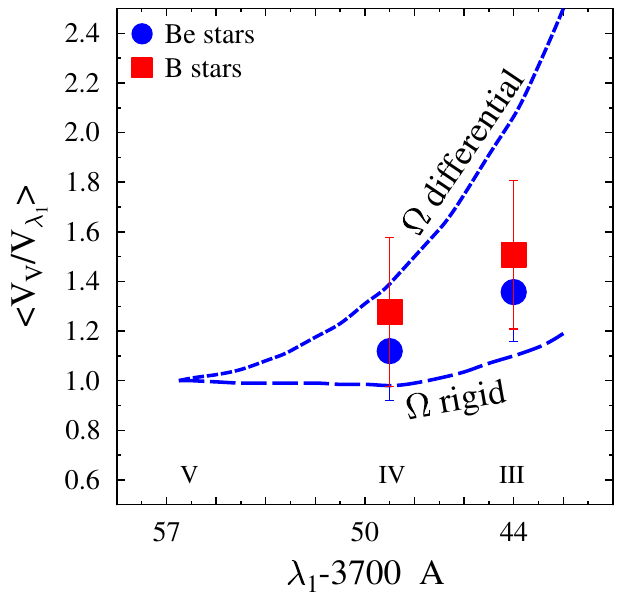
(cid:105) ( (cid:104) V Figure 32. Average true rotational velocity ratios (cid:104) V V / V λ V = true rotational velocity of stars of 1 luminosity class V (dwarfs); V λ = true rotational velocity of stars of other luminosity classes identified 1 by an average λ 1 parameter marked in the abscissas) compared to the sequences of evolution of model ratios of true rotational velocities assuming rigid rotation over the MS evolutionary life span and complete differential rotation. Adapted from Zorec